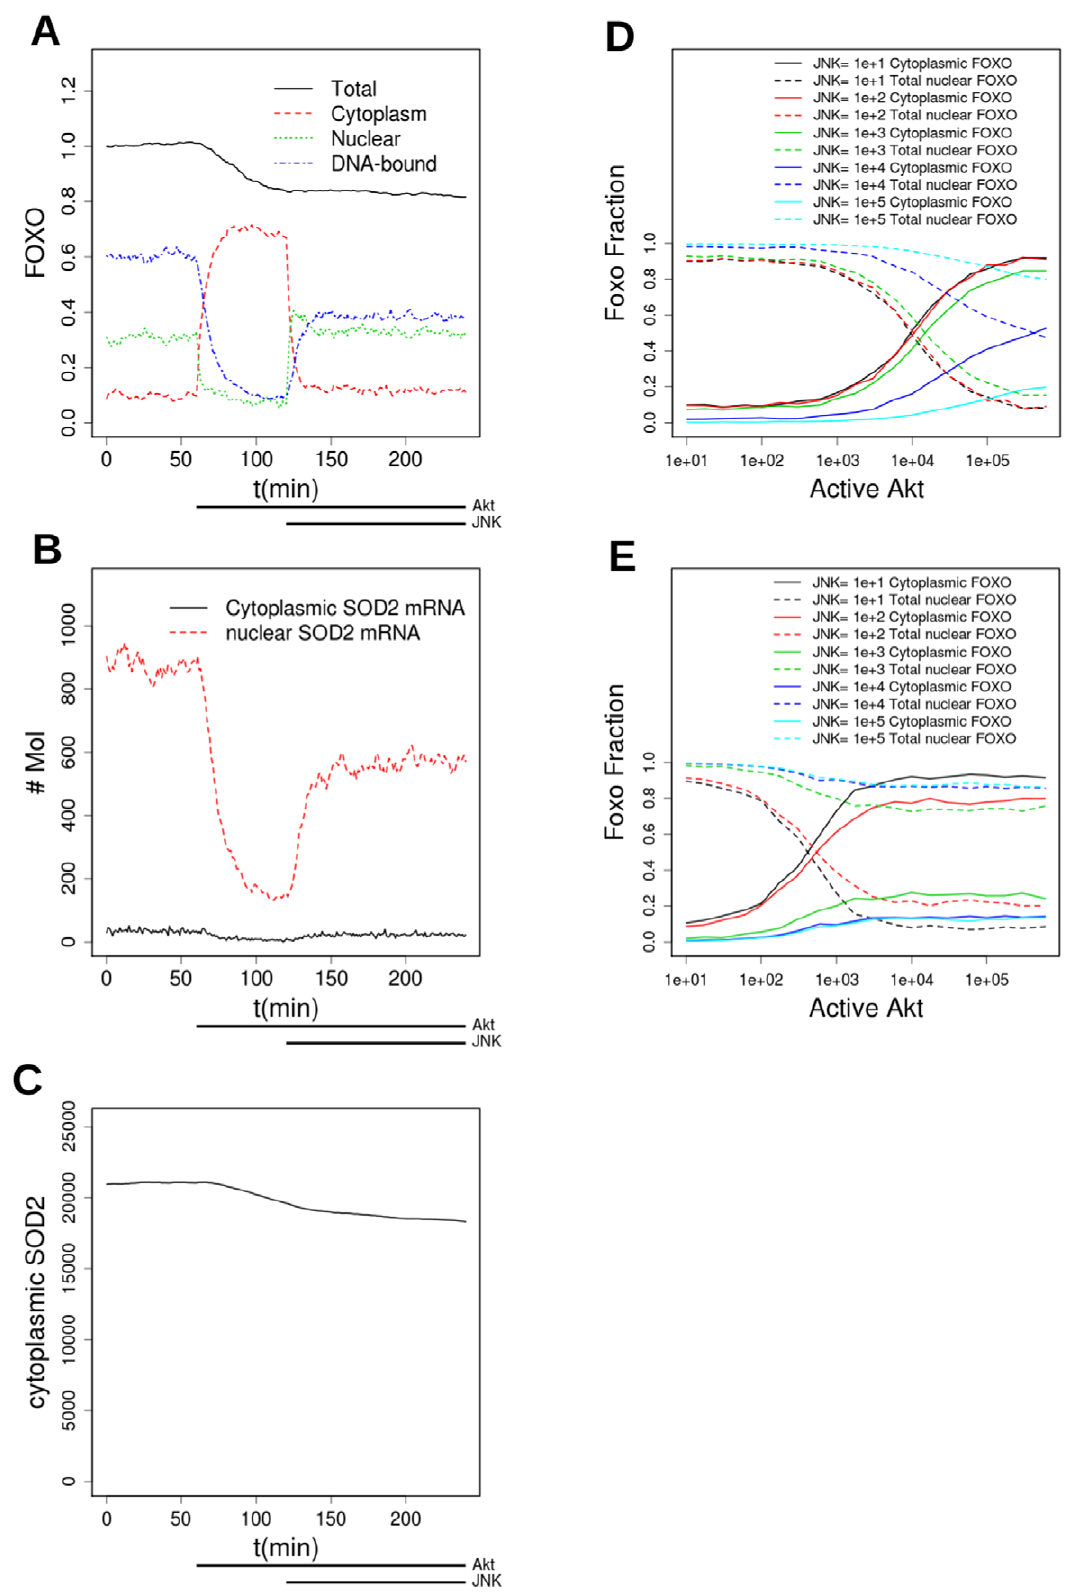
Figure 5. Combination of the effects of PTMs by JNK and Akt. A: FOXO is pre-equilbrated for 1440 minutes with Akt activity low (Akt=100) and JNK inactive (JNK=0). The PP2A level is 10 4 . At t=60 min FOXO is set to high activity (5 6 10 4 ); the PP2A level is 10 4 . At t=120min the level of active JNK is also set to 5 6 10 4 (times of high kinase activity shown by dosing bars below the plots). The graph shows the total amount of FOXO and